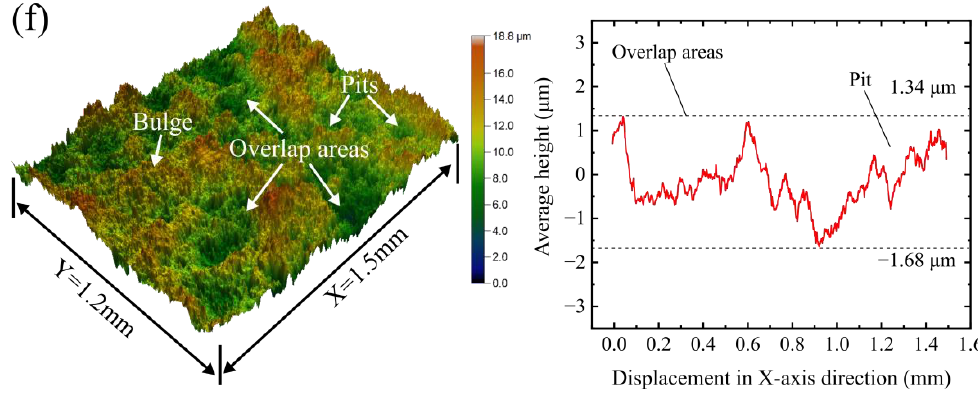
Figure 3. Three-dimensional morphology and two-dimensional profile of specimens: ( a ) control group T0; ( b ) group T1; ( c ) group T2; ( d ) group T3; ( e ) group T4; ( f ) group T5.